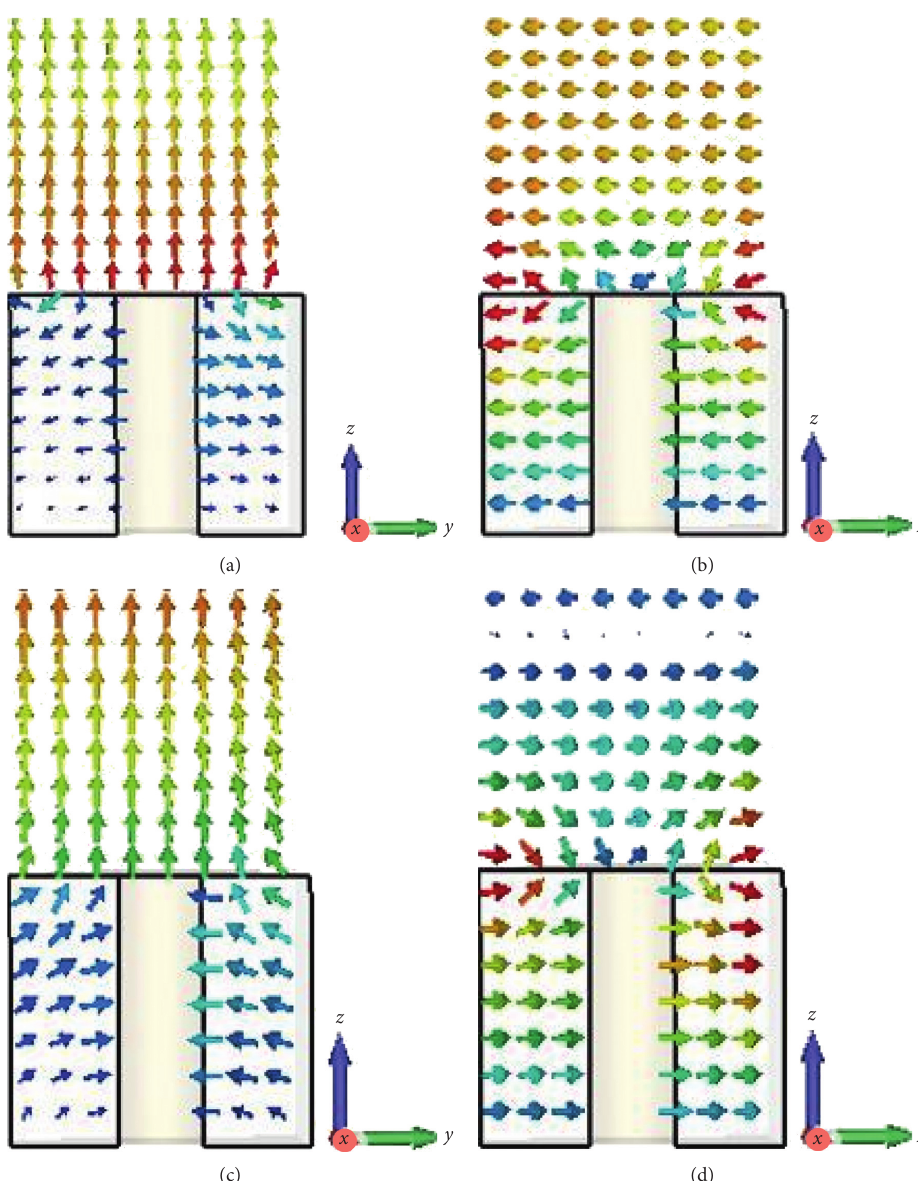
Figure 7: Sectional view of electric field distribution of the four eigenmode in yz plane. (a) Mode 1. (b) Mode 2. (c) Mode 3. (d) Mode